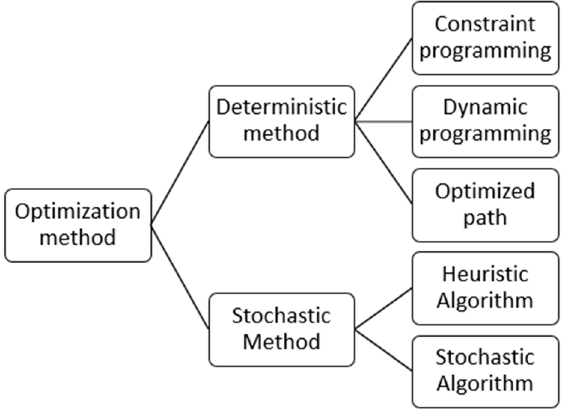
Figure 9. Optimization process, as adapted from Ref. [70].